Question: What type of chart is this?
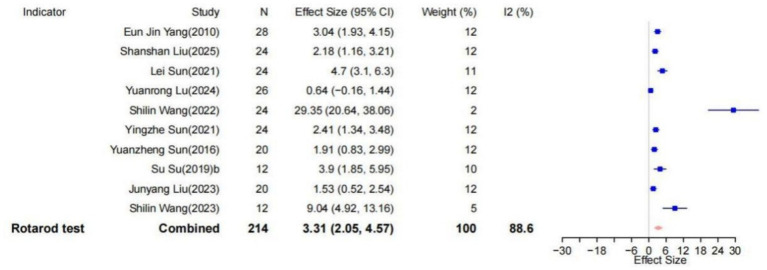
Answer: forest